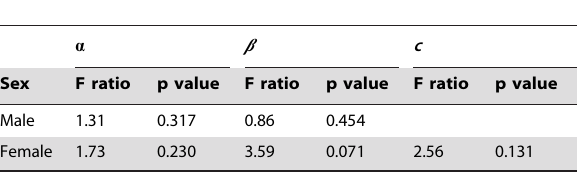
Table 1. Treatment effects on Gompertz (male) and Gompertz-Makeham (female) mortality parameters when measured under 100% O 2 at generation 15(10